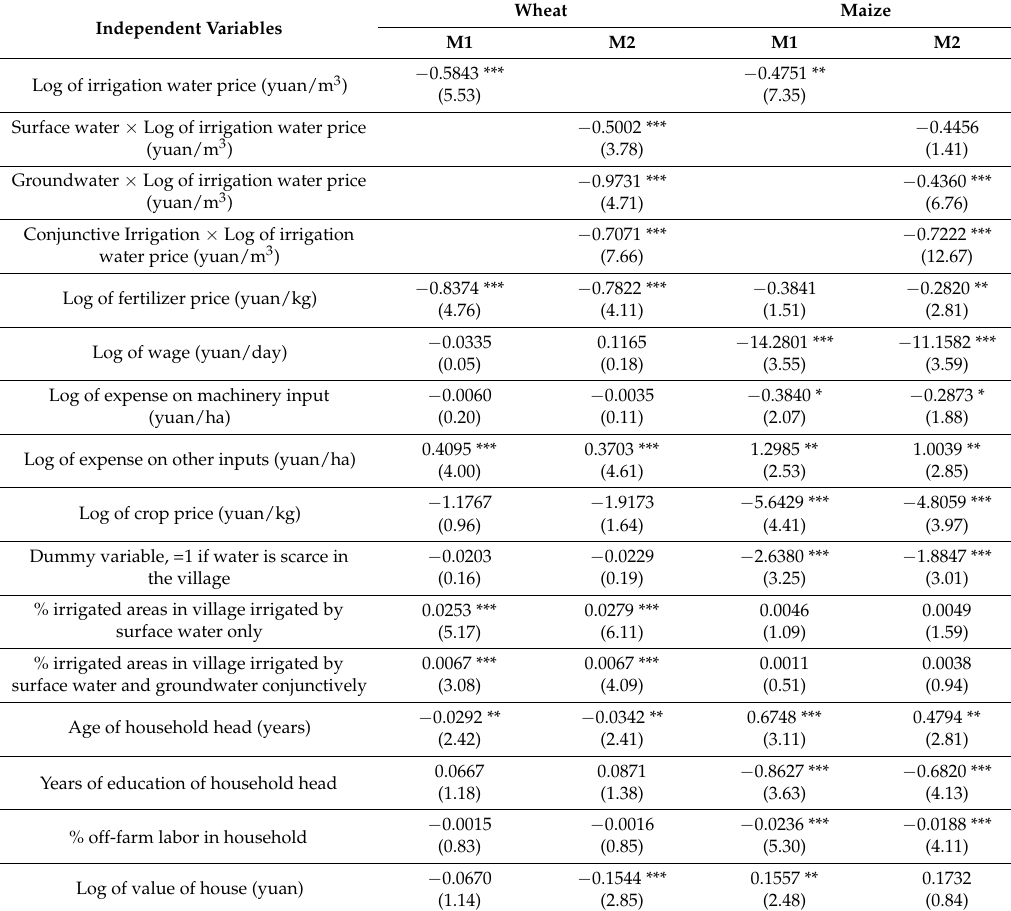
Table 3. Dependent variables: Log of irrigation application rates (m 3